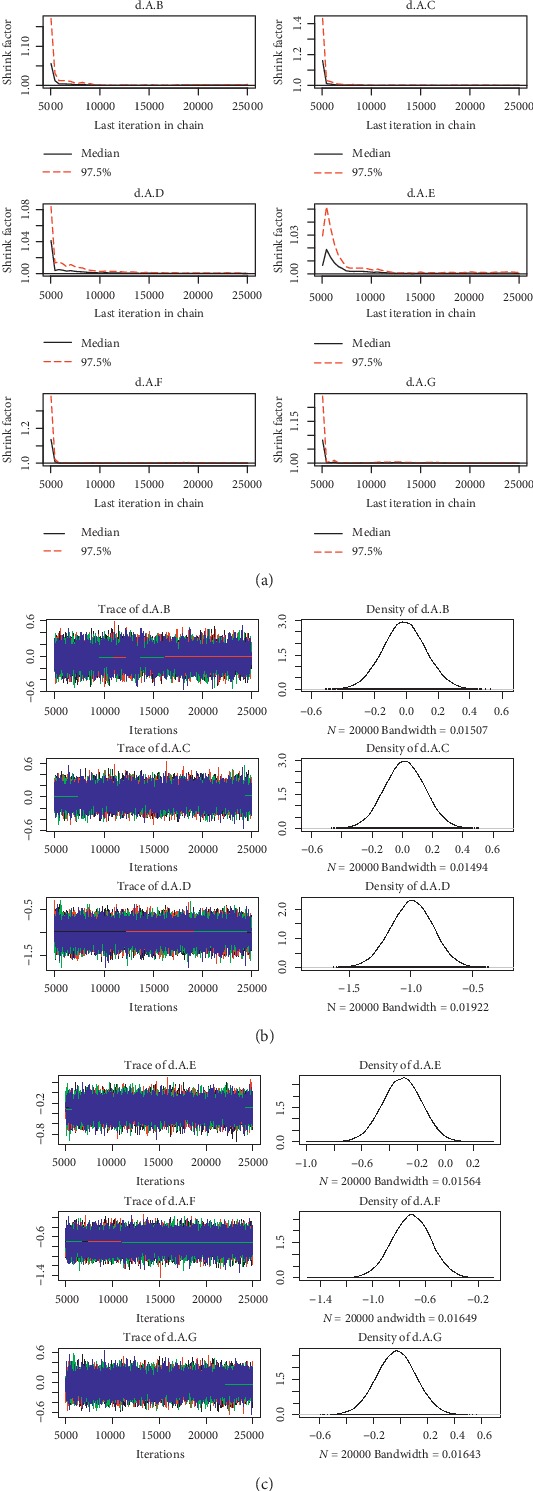
Brooks-Gelman-Rubin diagnostic plot and density plot for the safety of the comparison among different treatments of patients with moderate renal function.